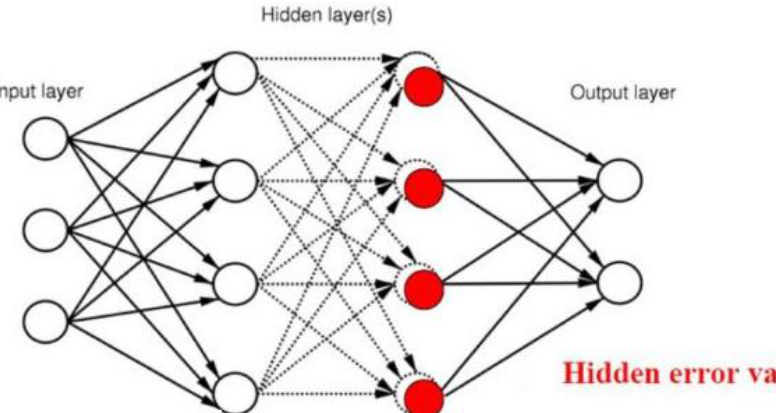
Figure 3. Forward and backward propagation.